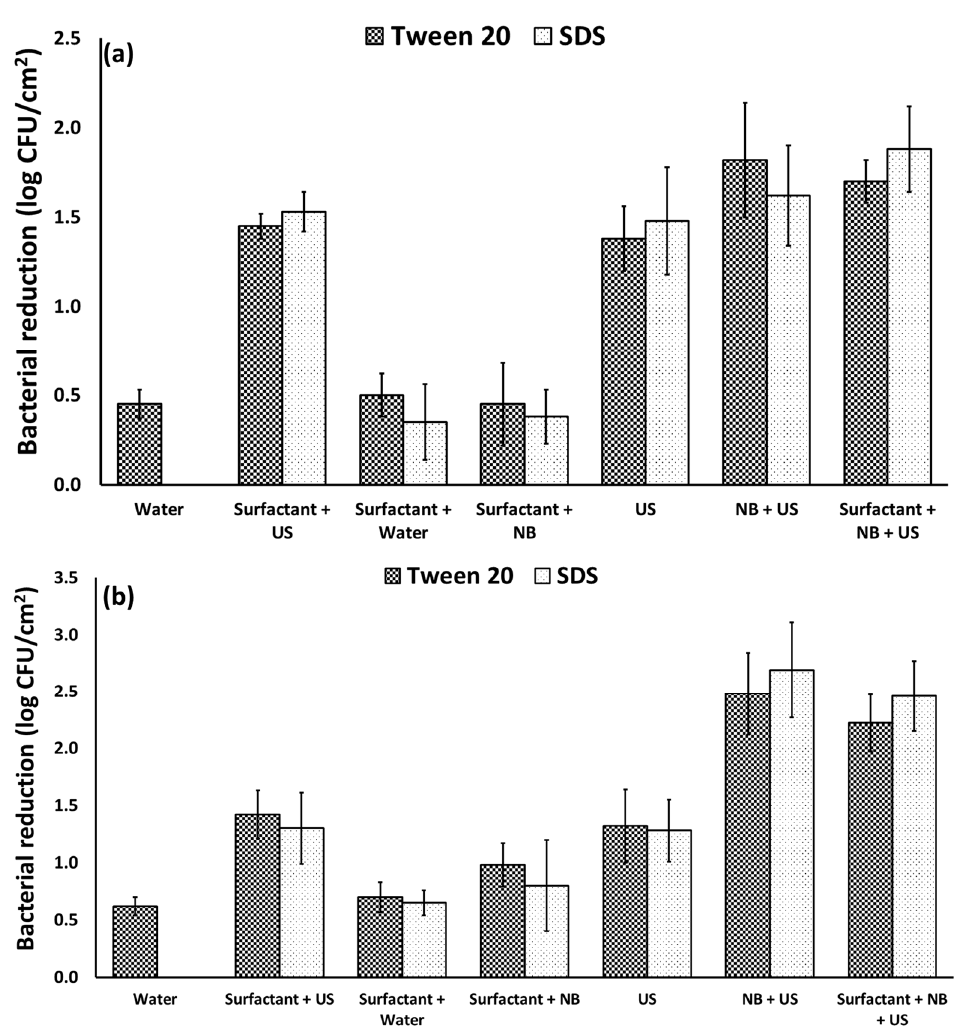
Figure 3. ( a ) L. innocua and ( b ) E. coli reduction on spinach leaves treated with different solutions for 10